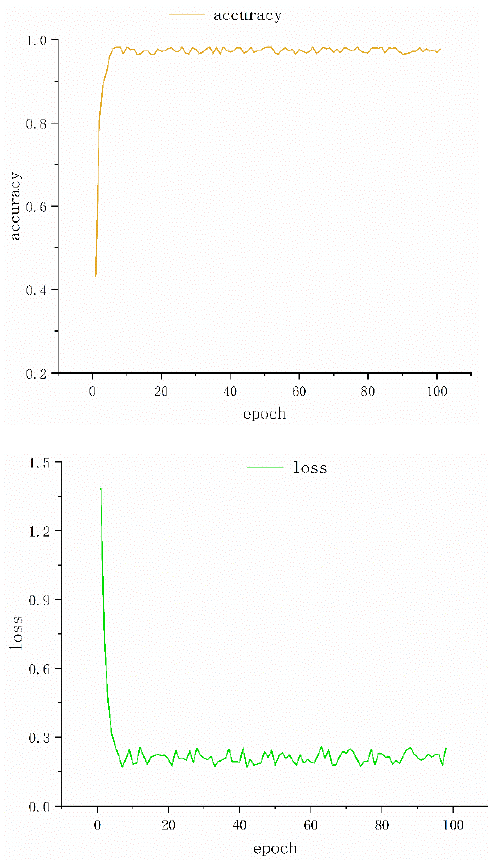
Figure 8. Loss and accuracy of test set.